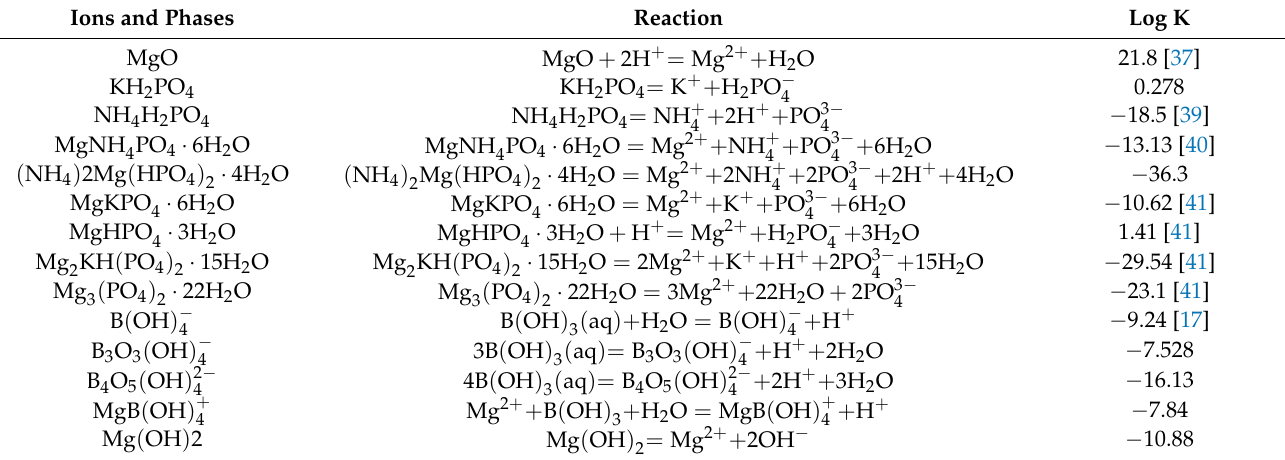
Table 2. Thermodynamic data of MPC pastes.